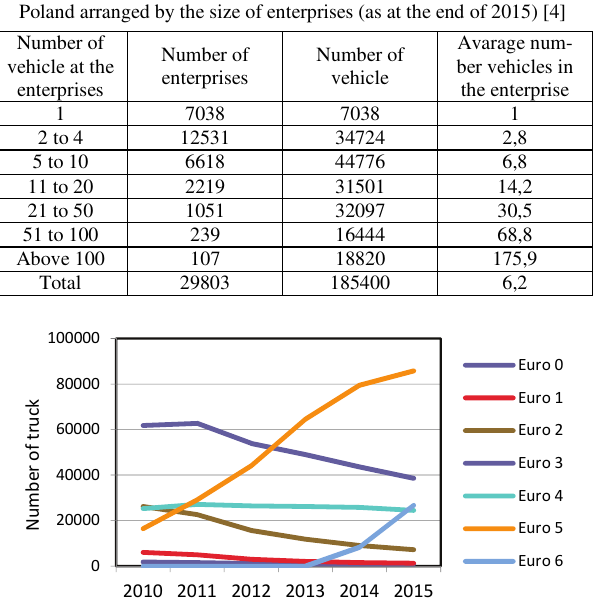
Fig. 6. Number of trucks at the international transport companies according to the pollutants emission standards in 2010 and in 2015 in Poland [4]